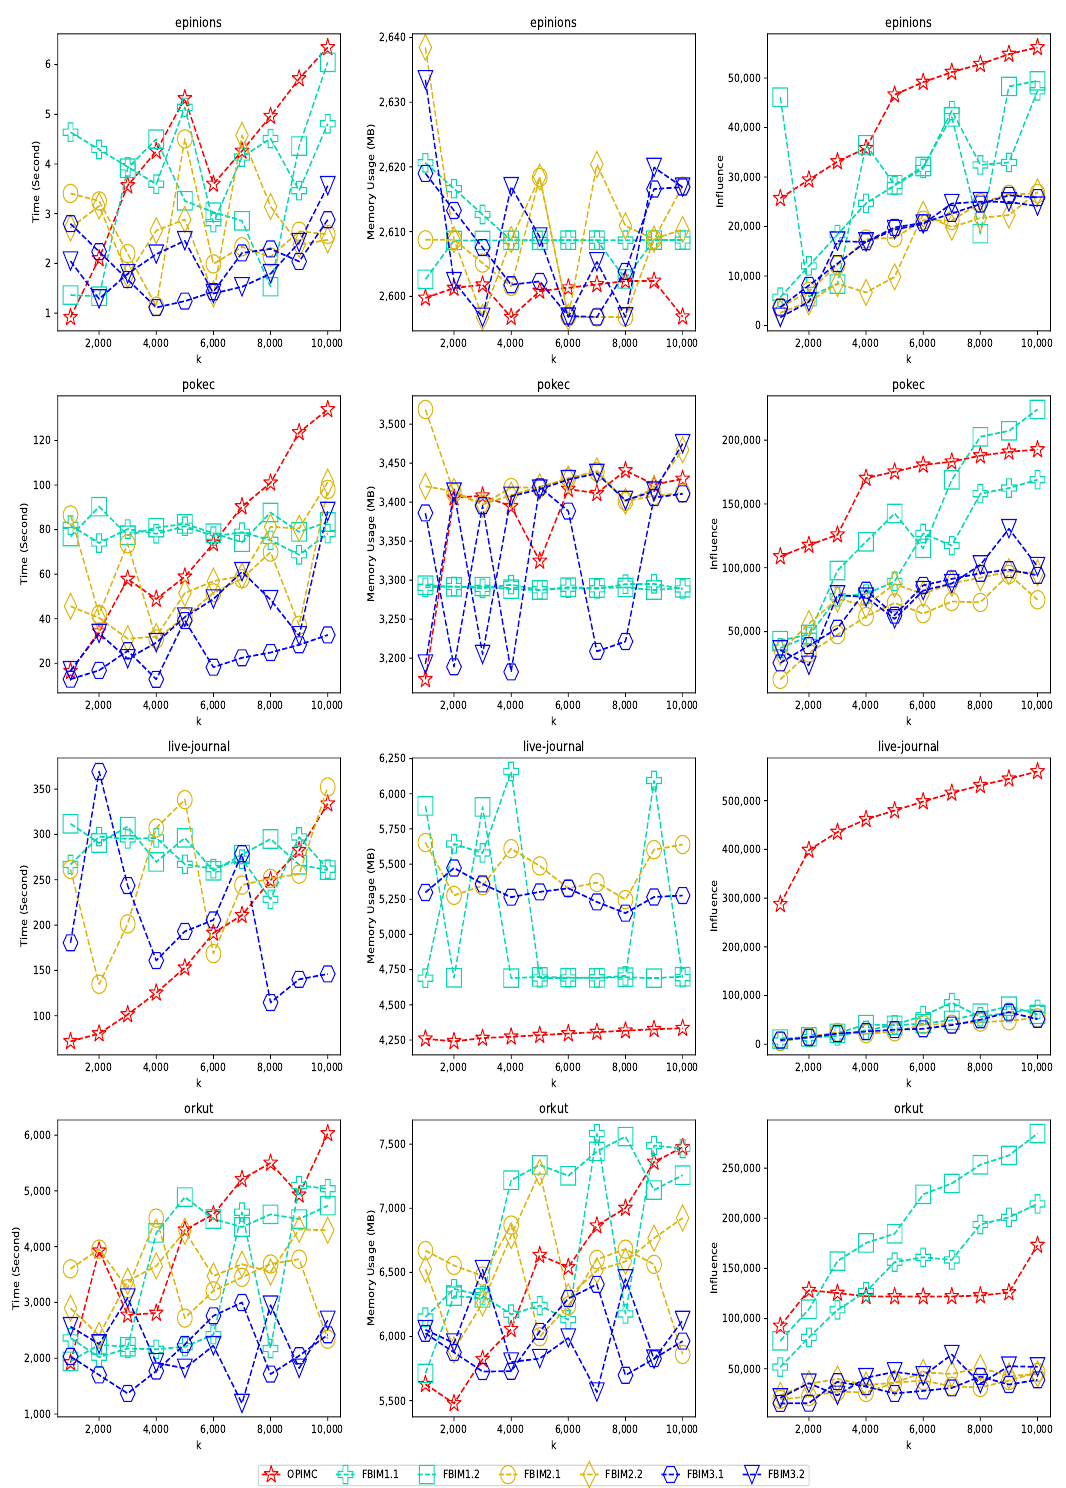
Figure 2. Running time, memory usage, and influence for Experiment 1 under the IC